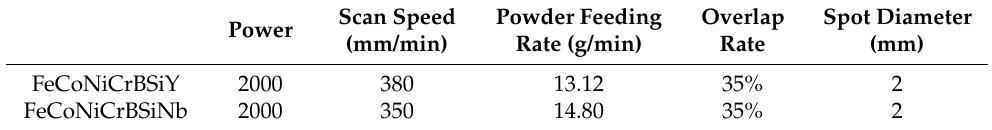
Table 3. Laser cladding process